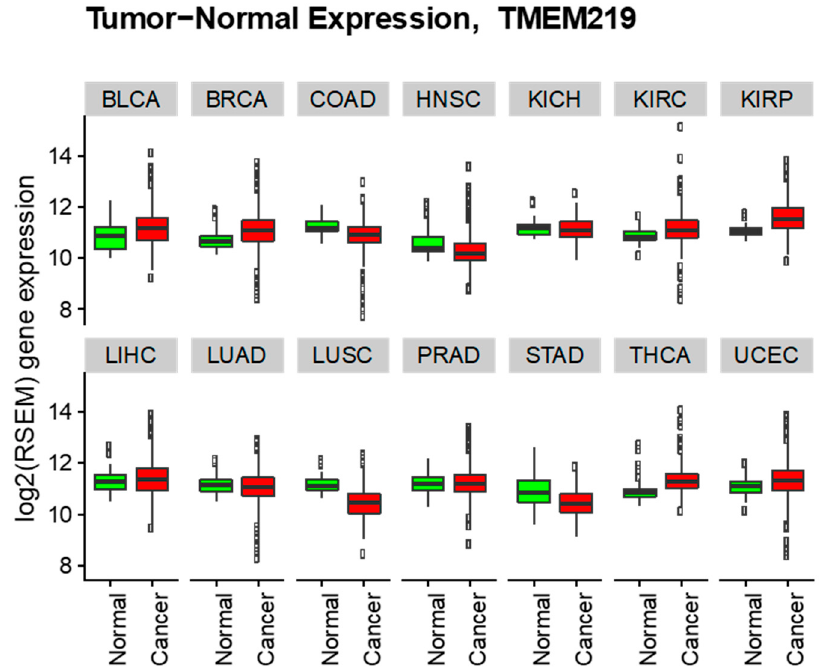
Figure 4. Cancer vs. normal TMEM219 log2 RSEM gene expression boxplots (all cancer). Description of abbreviations presented in Table 2.